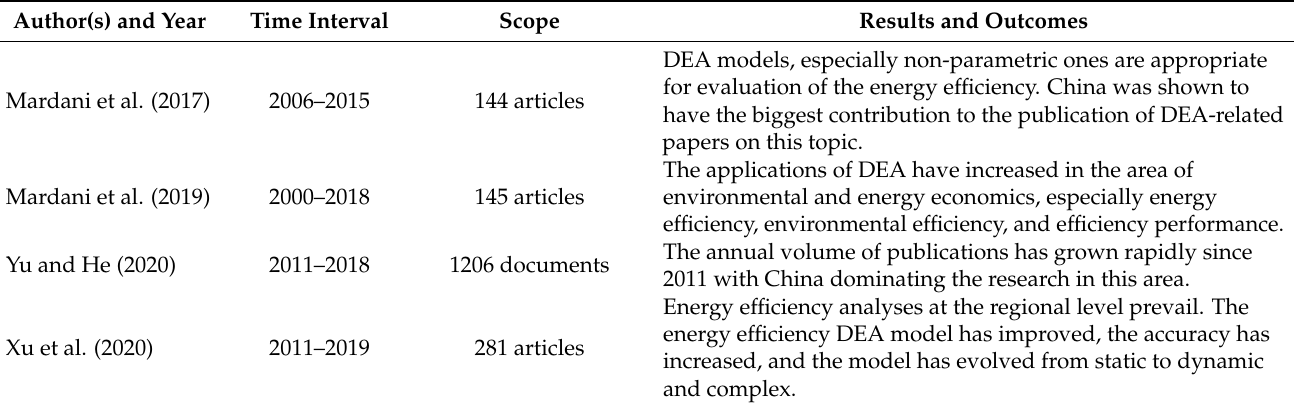
Table 1. Summary of literature reviews using the DEA approach to study energy